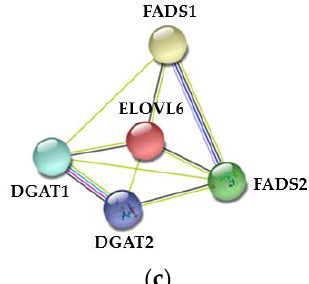
Figure 8. Relative expression of genes related to fatty acid metabolism after transfecting with the ( a ) mimic and ( b ) inhibitor ( n = 9). NC represents the negative control. Data were presented as mean ± standard error (SE). * represents p < 0.05, indicating significant differences between the groups. ( c ) A protein–protein interaction (PPI) network of FADS1 and genes related to fatty acid metabolism, including FADS2 , ELOVL6 , DGAT1 , DGAT2 .